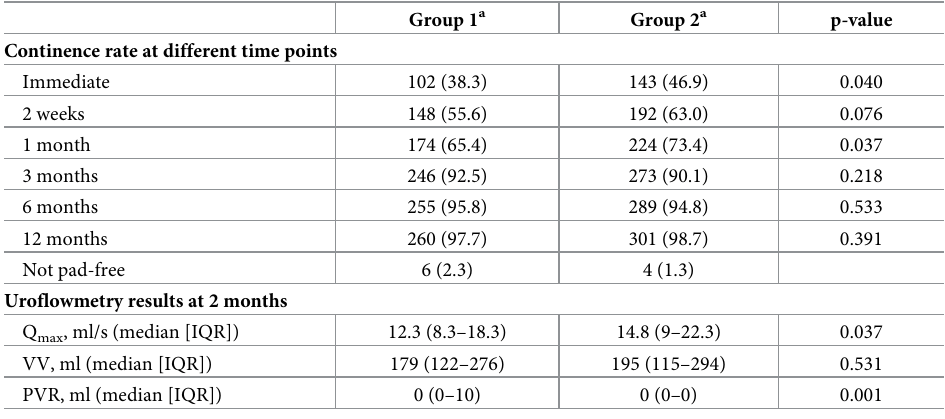
Table 3. Continence rates and uroflowmetry